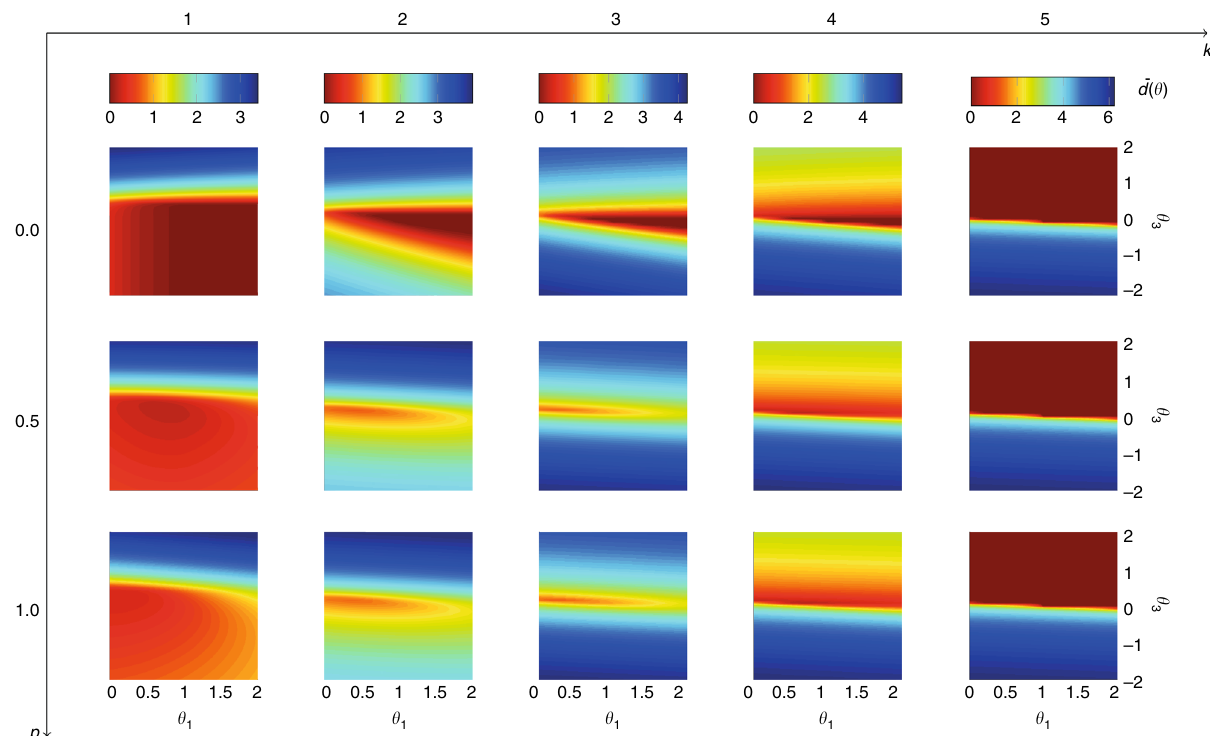
Fig. 10 Results of the test on Small-World networks of fi xed size N ¼ 11 agents, different values of outdegree k , and of rewiring probability p . For each pair ð k ; p Þ we consider n ¼ 10 different realizations and we compute the average distance function of agent i in the j th realization. For illustration and computational purposes, we restrict the parameter space to ~ Θ ¼ ½ 0 ; 2 (cid:4) ´ 0 ´ ½(cid:3) 2 ; 2 (cid:4) . The plot shows the heat map of (cid:2) d θ ð Þ ¼ log ð ~ d ð θ Þ þ 1 Þ in the ð θ 1 ; θ 3 Þ space, with lower values (thus more likely) associated with the red color. Source data are provided as a Source Data fi